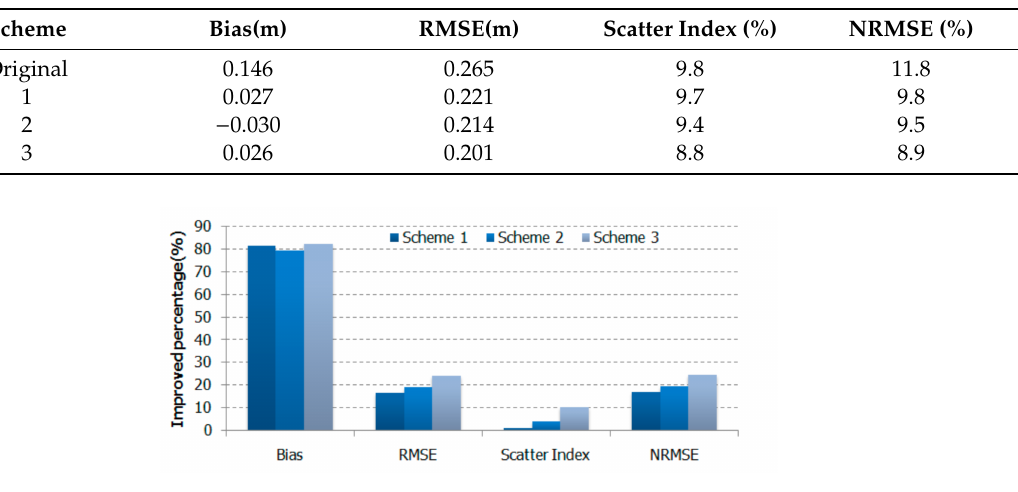
Figure 6. The percentage of the reduction of error by each SWH calibration DNN